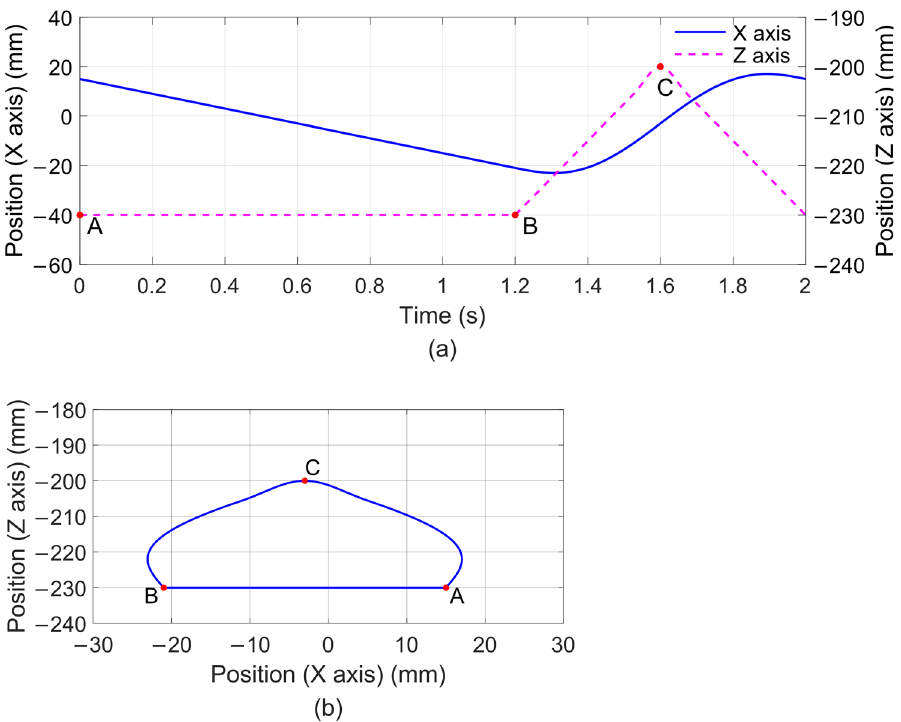
Figure 4. Foot trajectory relative to { O iB }: ( a ) Position variations in the X and Z directions; ( b ) Foot trajectory in the XZ plane.